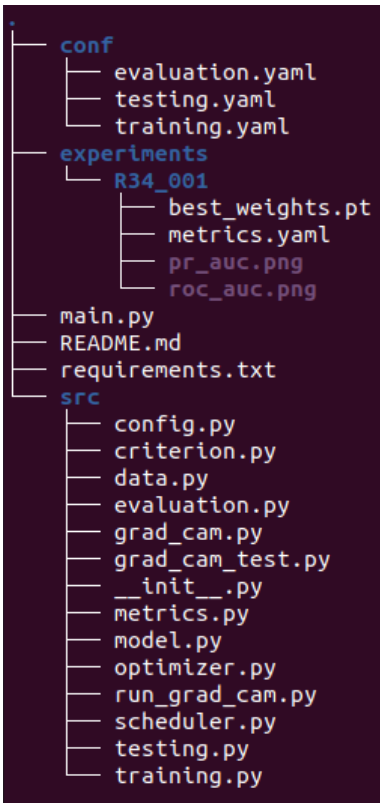
Figure A8. Framework repository